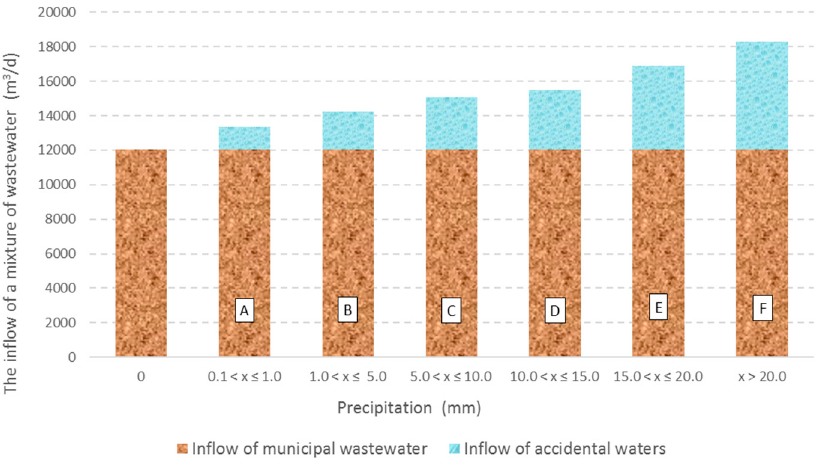
Figure 4. Volume of municipal wastewater and volume of accidental water (rainwater) flowing into the wastewater treatment plant against the background of precipitation in particular groups.